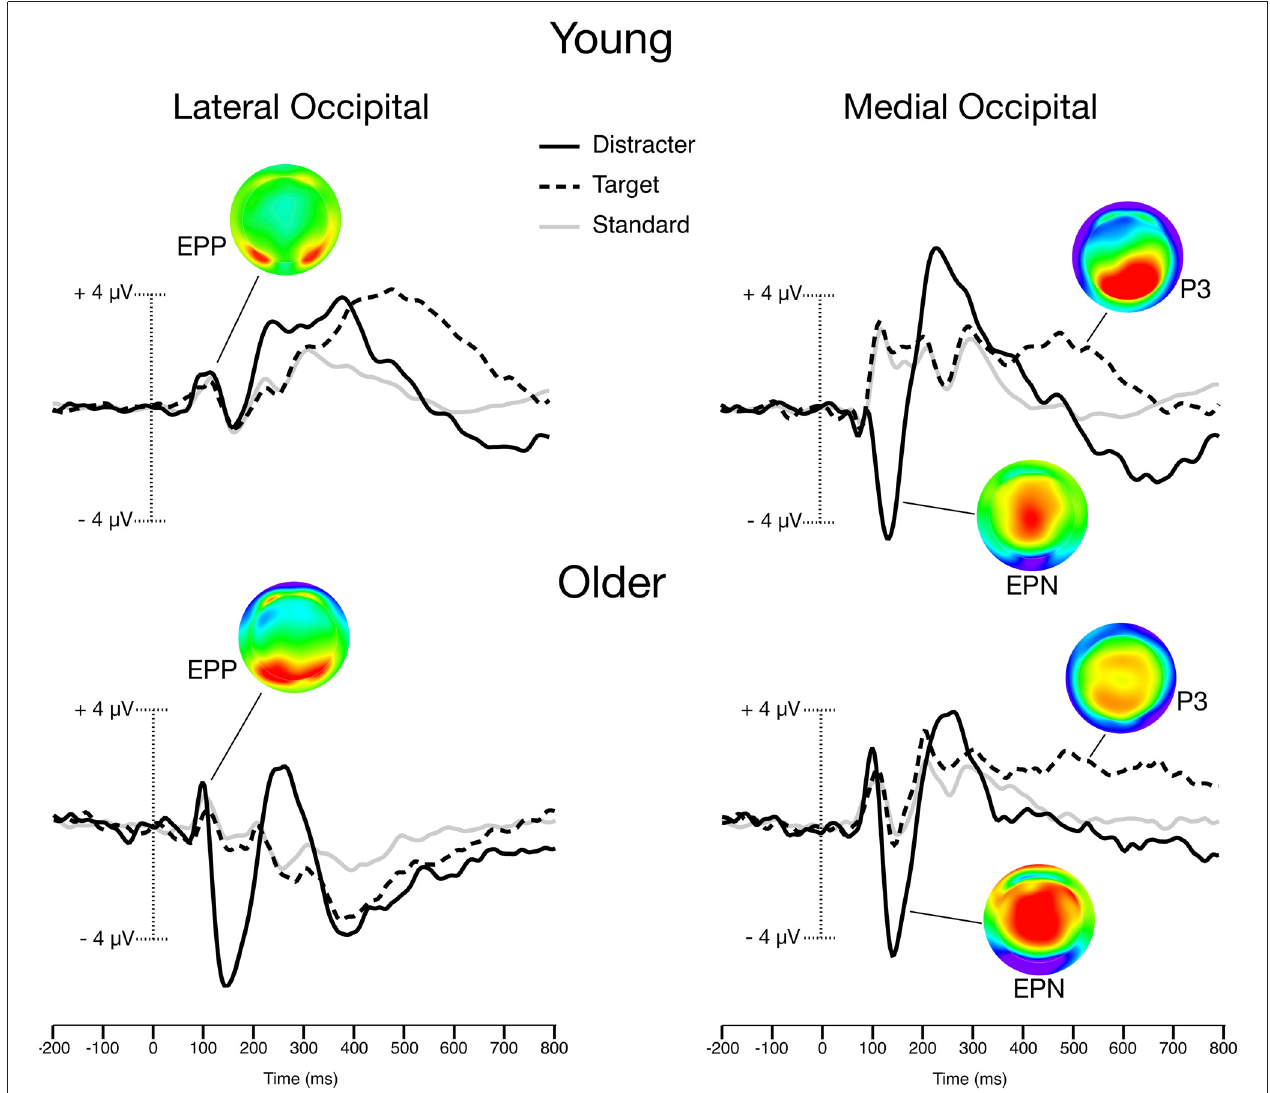
FIGURE 2 | Grand-averaged Event-related potentials (ERPs) from the color distracter block trials. Scalp maps illustrate the peak amplitudes of color distracter processing for early posterior positivity (EPP; 100 ms), Early Posterior Negativity (EPN; 140 ms), and P3 (400 ms). Lateral occipital waveforms were averaged from O1, O2, PO7, and PO8 electrodes. Medial occipital waveforms were averaged from O1, O2, and Oz